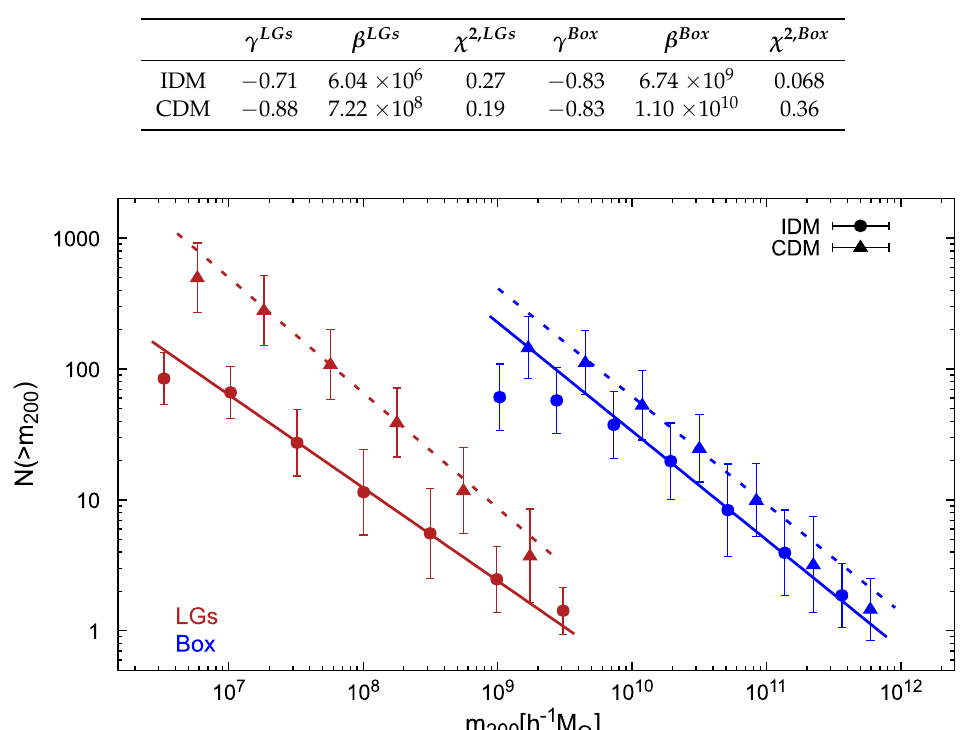
Figure 5. Cumulative number of subhalos, N ( > m 200 ) , as a function of subhalo mass, m 200 , in the case of IDM (circle symbols) and CDM (triangles) as obtained from Box (blue) and LG (red) simulations at z = 0. We also show the corresponding fits using Equation (8) with the best-fit parameters reported in Table 2 (solid coloured